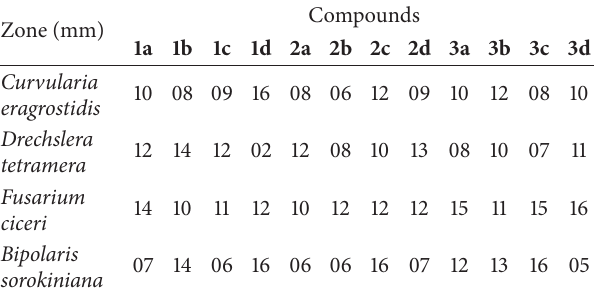
Table 3: Antifungal activity of synthesized